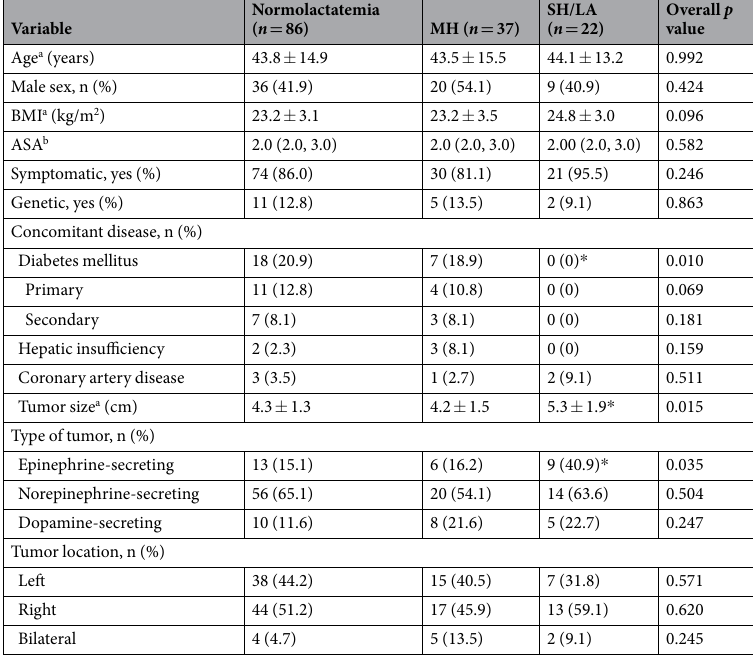
Table 1. Patient demographics and tumor characteristics. MH, moderate hyperlactatemia; SH/LA, severe hyperlactatemia/lactic acidosis; BMI, body mass index; ASA, American Society of Anesthesiologists’ classification. * P < 0.05 vs the normolactatemia group. a Mean ± standard deviation; b median (25th percentile, 75th percentile).